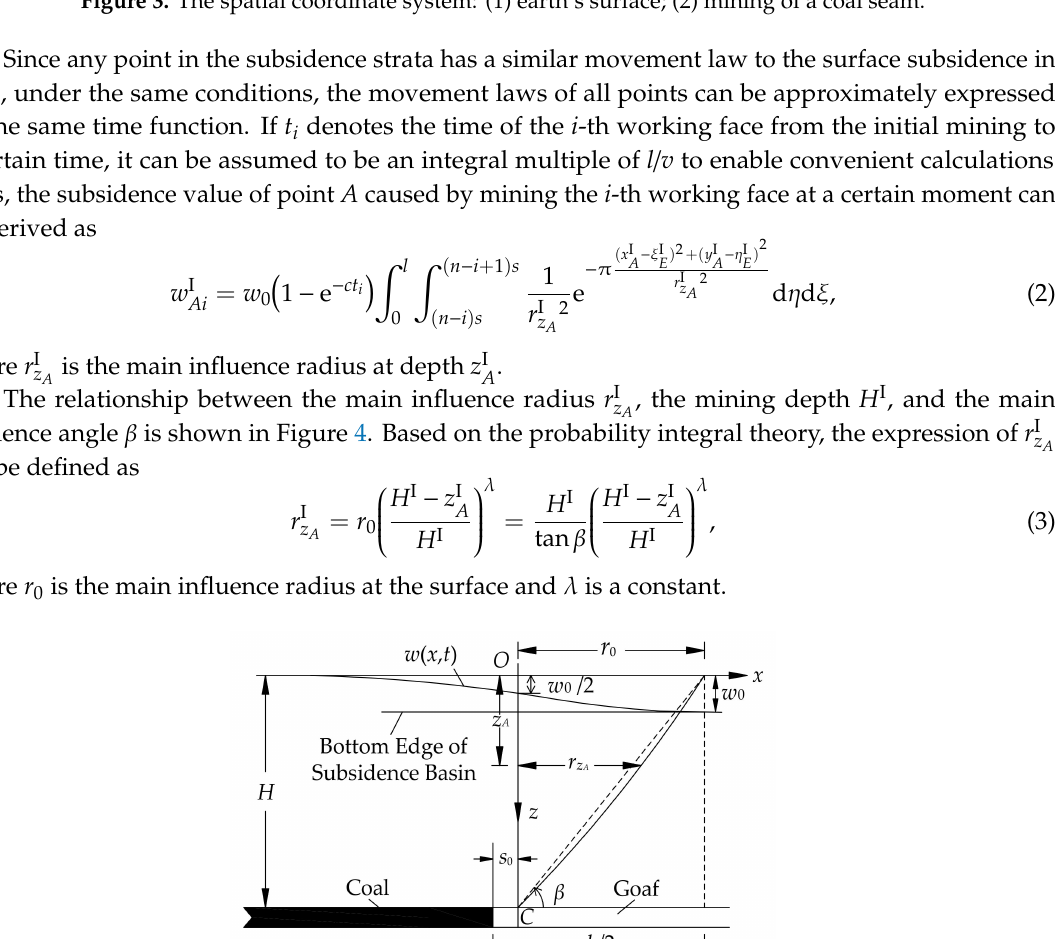
Figure 3. The spatial coordinate system: (1) earth’s surface; (2) mining of a coal seam.